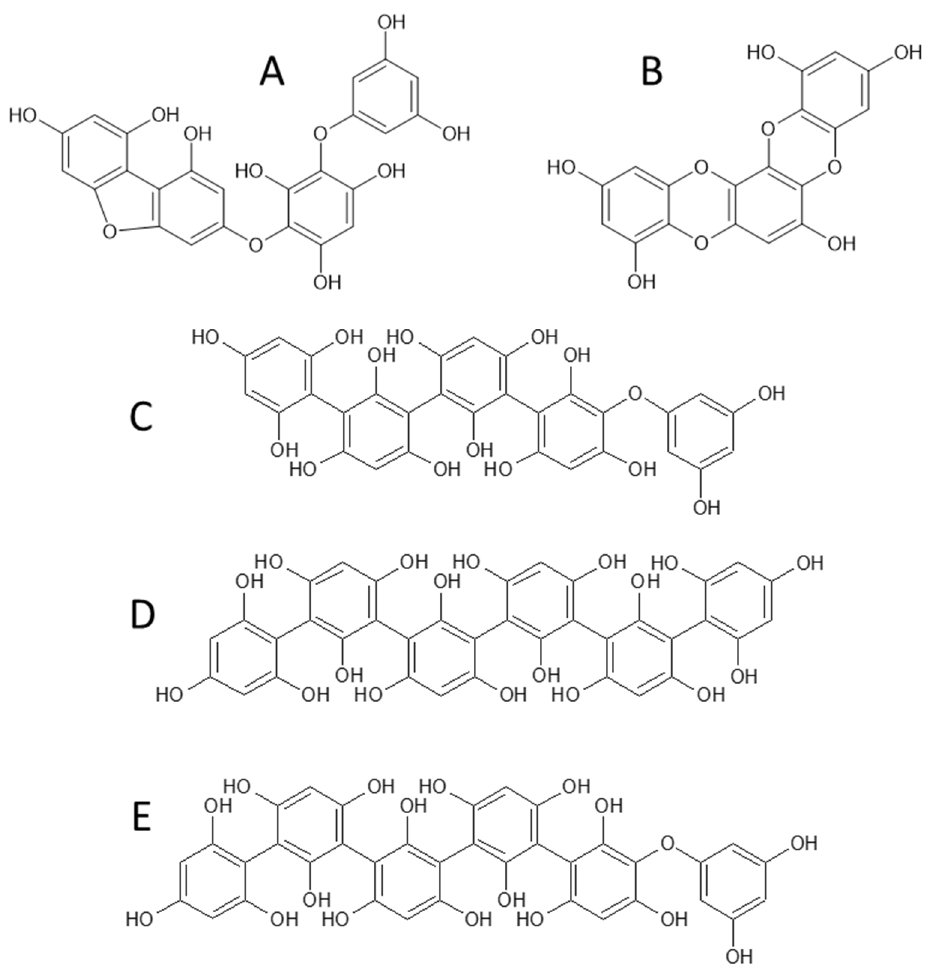
Figure 7. Chemical structure of the compounds tentatively identified in F5: ( A ) eckstolonol, ( B ) fucofurodiphlorethol, ( C ) trifucophlorethol, ( D ) hexafucol, and ( E ) tetrafucophlorethol. The compound eluting at 7.0 min presented a deprotonated molecular ion at m/z 479, indicating a dehydroxylated phloroglucinol tetramer. This further fragmented into the product ions at m/z 461, corresponding to the loss of water, at m/z 435, which results from the internal cleavage of benzene ring structures and elimination of 44 Da; at m/z 353, as a consequence of the elimination of a phloroglucinol unit (PGU); and other fragments such as m/z 417 or m/z 313, which are resultant from the combination of the previous losses ( − 44 − 18 and − PGU − 44, respectively). A compound presenting a similar retention time as well as an identical MS spectrum has been described previously as fucofurodiphlorethol (Figure 7B) owing to its structural resemblance to fucofuroeckol ([M − H] − at m/z 477), except for the absence of the dioxin ring between the two inner phloroglucinol moieties, which would explain the 2 Da difference between their deprotonated ions. Although this compound is not usually described in the literature, recent works reported its presence in two different F. vesiculosus extracts, namely a microwave-assisted extract (using 57% eth- anol) [41] and a conventional solid-liquid extract (using 70% acetone) [33]. The compounds eluted at 3.1 min ([M − H] − at m/z 621) and 4.9 min ([M − H] − at m/z 745) also presented retention times and MS spectra similar to those of trifucophlorethol (Figure 7C) and hexafucol (Figure 7D), assigned in our previous work [33], respectively. Interestingly, the isomer of the compound with a [M − H] − at m/z 745 that eluted at 3.9 min revealed a fragmentation pattern slightly different from the one eluting at 4.9 min. In this case, the formation of the product ions such as m/z 619 and 601 denotes the loss of a phloroglucinol moiety and a phloroglucinol plus water, respectively, which is indicative